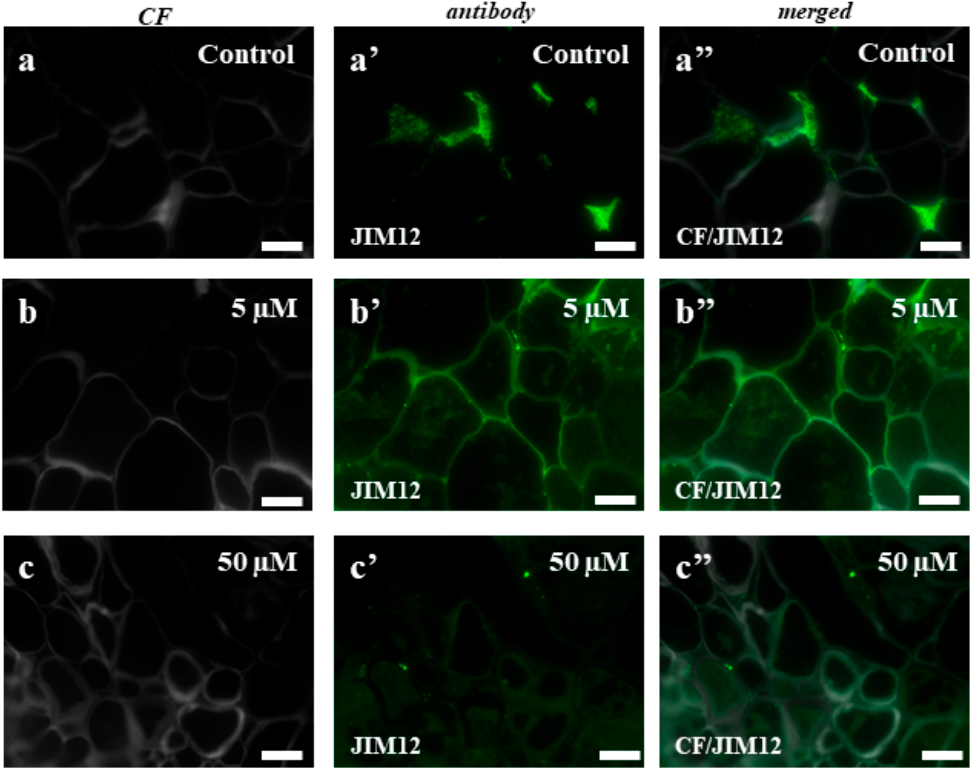
Figure 9. Immunolocalization of JIM12 in the Brachypodium callus. ( a – a” ): control callus. ( b – b” ): callus that has been treated with 5 µM of 5-azaC. ( c – c” ) callus that has been treated with 50 µM of 5-azaC. The greenish background on these photomicrographs is due to the autofluorescence. Scale bars, 10 µm.